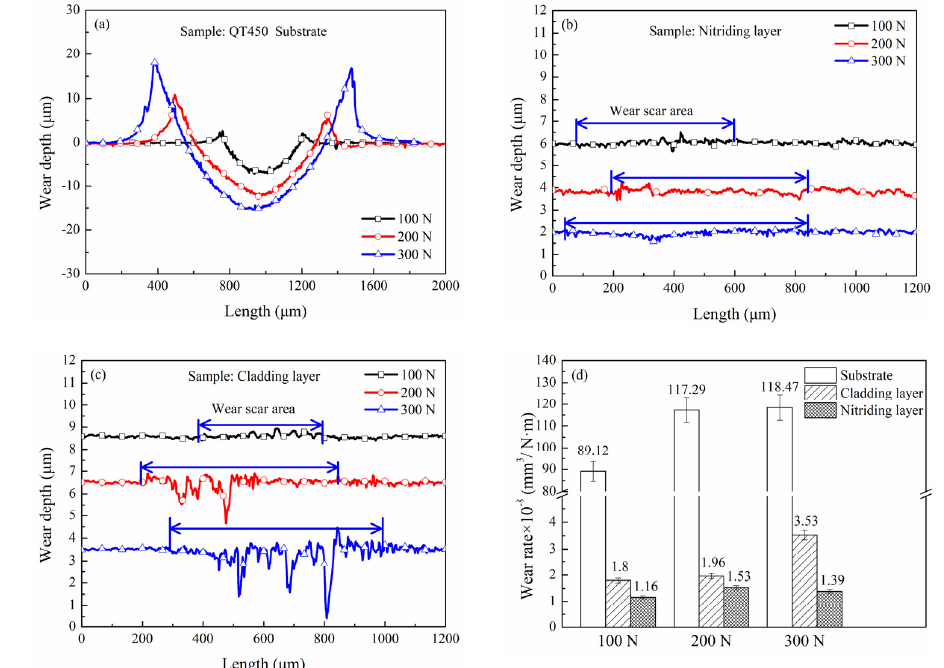
Figure 6. The wear depth of: ( a ) substrate, ( b ) nitriding layer, ( c ) cladding layer, and ( d ) the wear rates at different loads.